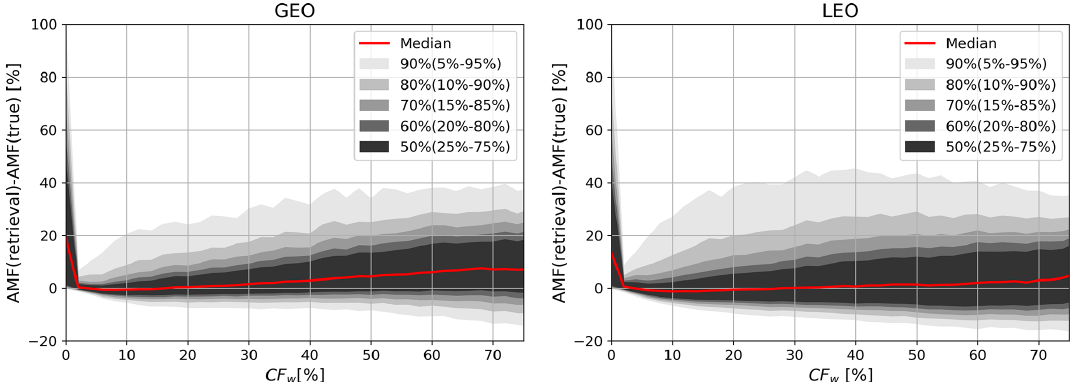
Figure 4. Distribution of the NO 2 AMF bias as a function of the weighted radiometric cloud fraction, CF w , for geostationary and low-earth- orbiting geometries. Results are shown for the retrieval using the O 2 –O 2 cloud correction. Results are similar for the O 2 –A band-based cloud